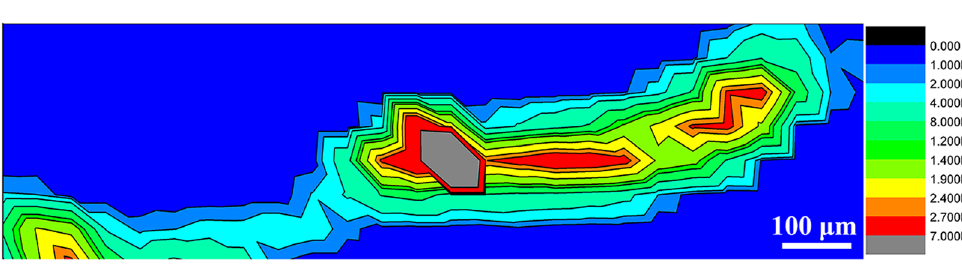
Figure 4. Micro-X-ray fluorescence ( μ -XRF) spectroscopy of Se element in C . elegans after 48-h